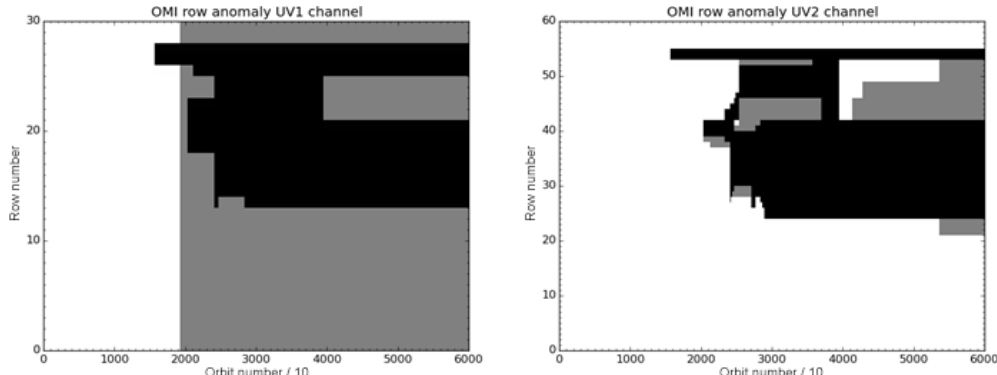
Figure 22. Row-anomaly evolution for the UV1 and UV2 channels. Black areas show full RA-affected orbits, and gray areas mark partial orbits (northern part). The VIS channel looks similar to the UV2